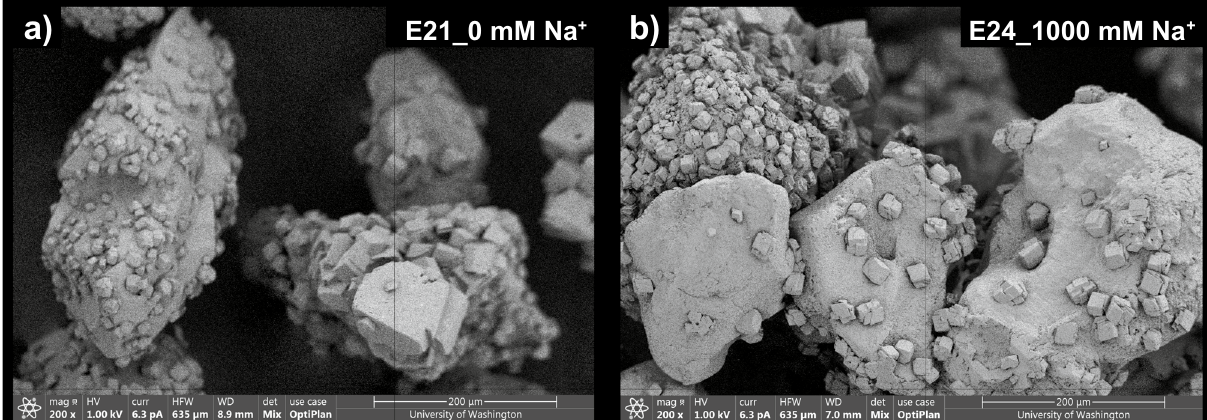
Figure 9. SEM images of precipitates from ( a ) 0 mM Na + and ( b ) 1000 mM Na + specimens.